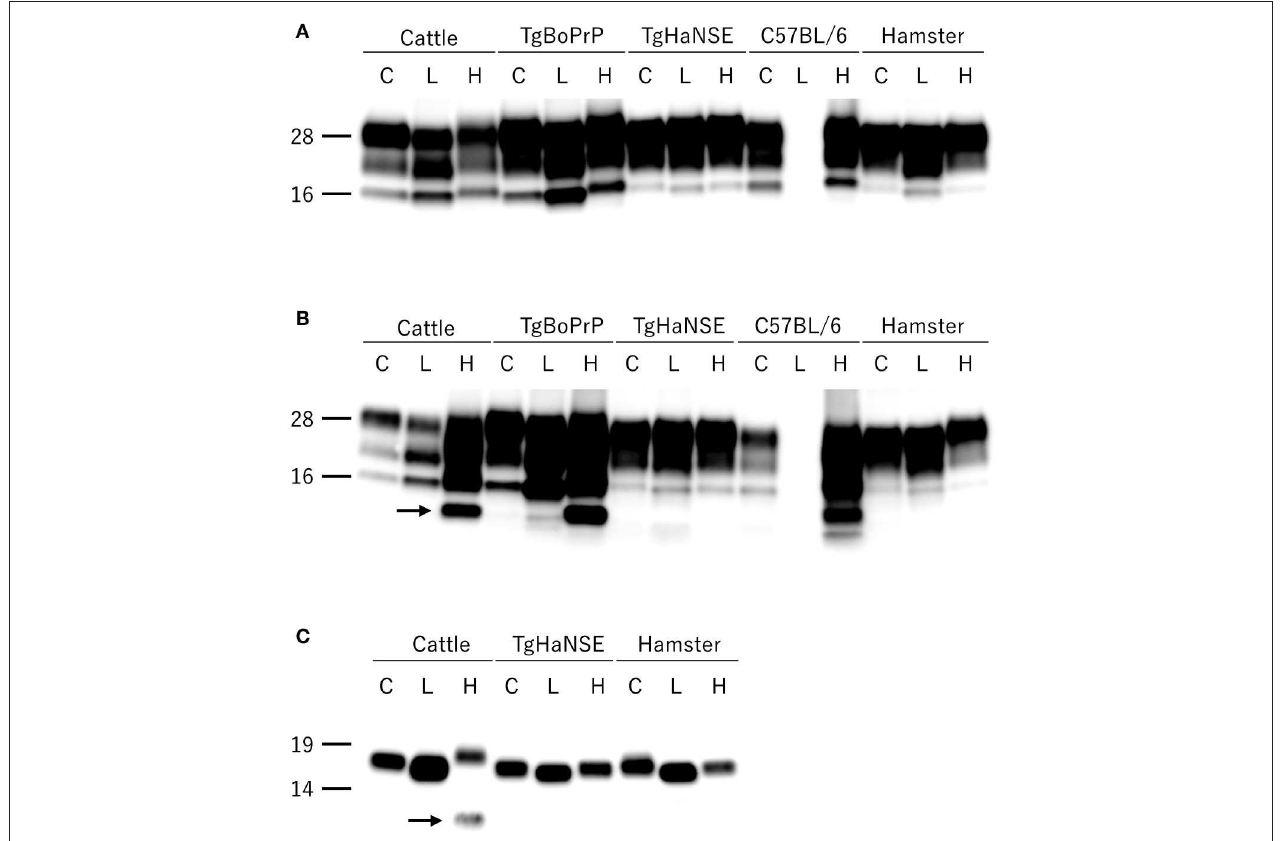
FIGURE 1 | Comparison of PrP res profiles among BSE strains in different host species. PrP res was detected with mAb 6H4 (A) and SAF84 (B) . PrP res was also detected with mAb SAF84 after PNGase deglycosylation (C) . PrP res banding patterns, which were specific to individual BSE strains in cattle, were conserved in TgBoPrP and wild-type (C57BL/6) mice, but not in TgHaNSE mice and Syrian hamsters. Further, the L-BSE prion was not transmissible to wild-type mice. All BSE strains showed similar molecular features between TgHaNSE mice and hamsters. Arrows indicate the ∼ 12-kDa small C-terminus PrP res fragment that is specific for the H-BSE strain, but was not detected in TgHaNSE mice and hamsters infected with the H-BSE prion. C, L, and H on the top of each panel indicate C-BSE, L-BSE, and H-BSE, respectively. Molecular markers are shown to the left (kDa).